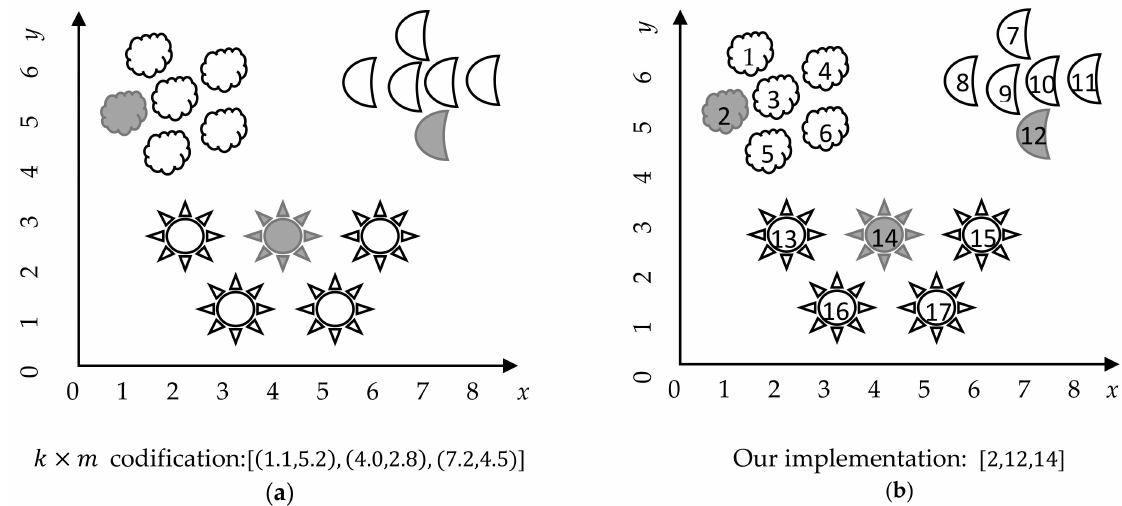
Figure 2. Dataset composed by 17 instances, described by m = 2 features (x and y), forming k = 3 clusters. The cluster centers are highlighted in gray. ( a ) The traditional k × m representation; ( b ) Our proposed implementation. Note that our implementation has a constant size k , despite the number of features in the